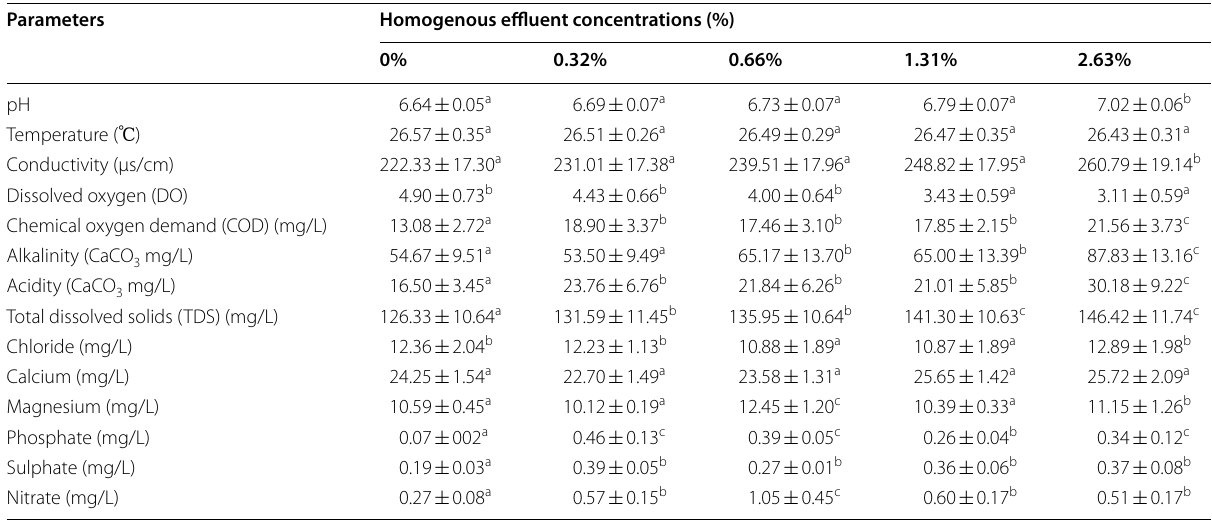
Table 2 Comparative means* ( SE) of physico-chemical parameters in the culture system during the exposure period ±